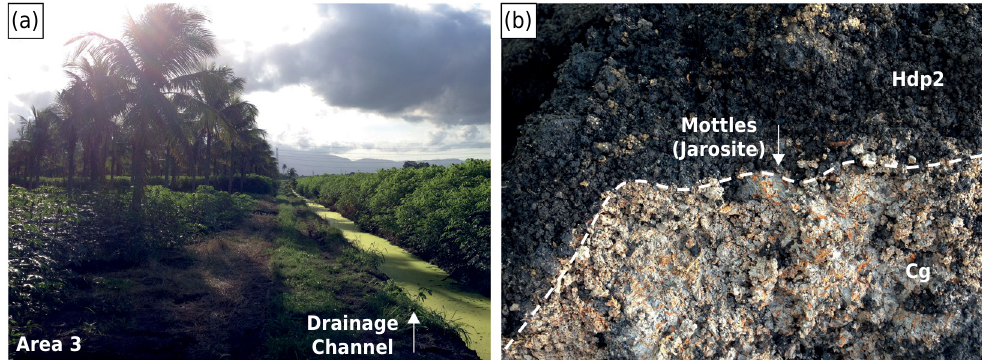
Figure 8. Drainage channel in Area 3 (a) and transition between superficial (Hdp2) and subsurface